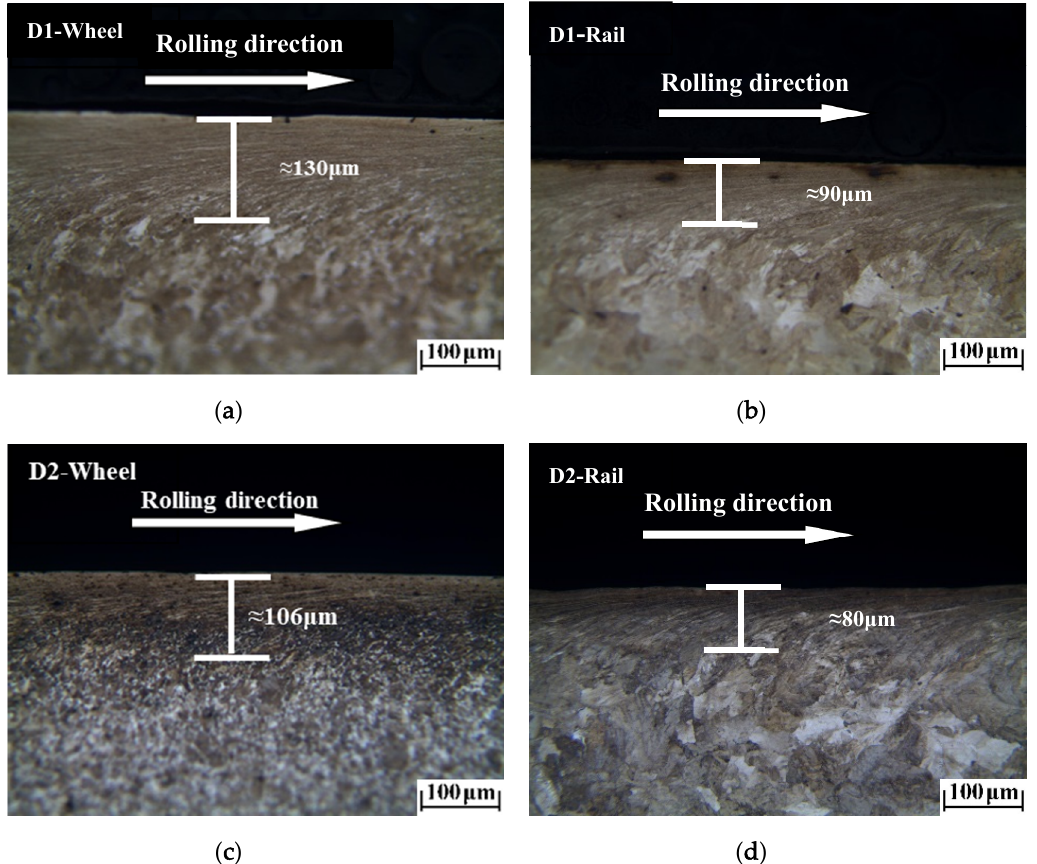
Figure 11. Plastic deformation of wheel and rail rollers at − 30 °C: (a) D1 wheel; (b) rail of D1 friction pair; (c) D2 wheel; (d) rail of D2 friction pair.